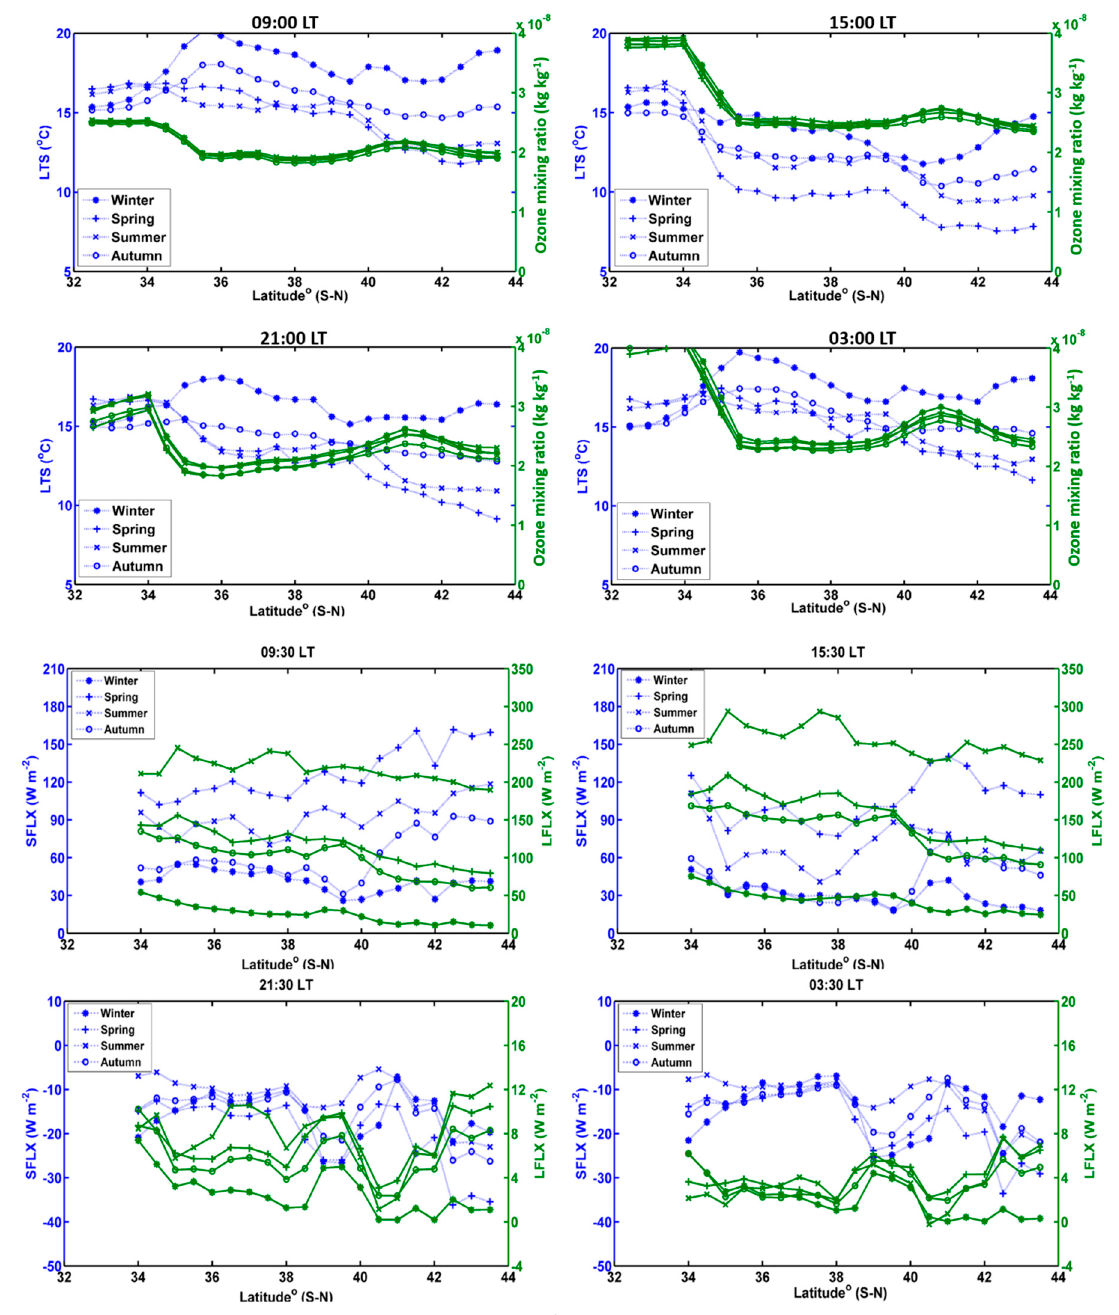
Figure 7. ( a ) Latitudinal variation of average surface temperature, relative humidity, pressure, and wind speed at 127.5°E longitude from 2008 to 2017 at 09:00, 15:00, 21:00, and 03:00 LT. ( b ) Latitudinal variation of average surface LTS, ozone mixing ratio, surface sensible heat flux (SFLX), and latent heat flux (LFLX) at 127.5°E longitude. However, the fluxes over land and at 09:30, 15:30, 21:30, and 03:30 LT.